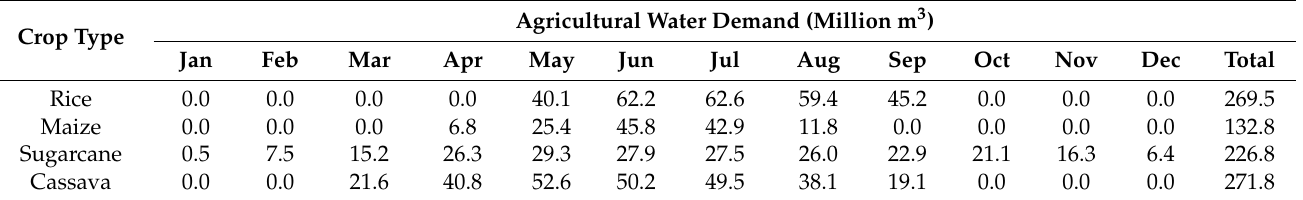
Table 4. Estimation of mean monthly agricultural water demand of major cash crops in the Lam Takong River Basin under historical